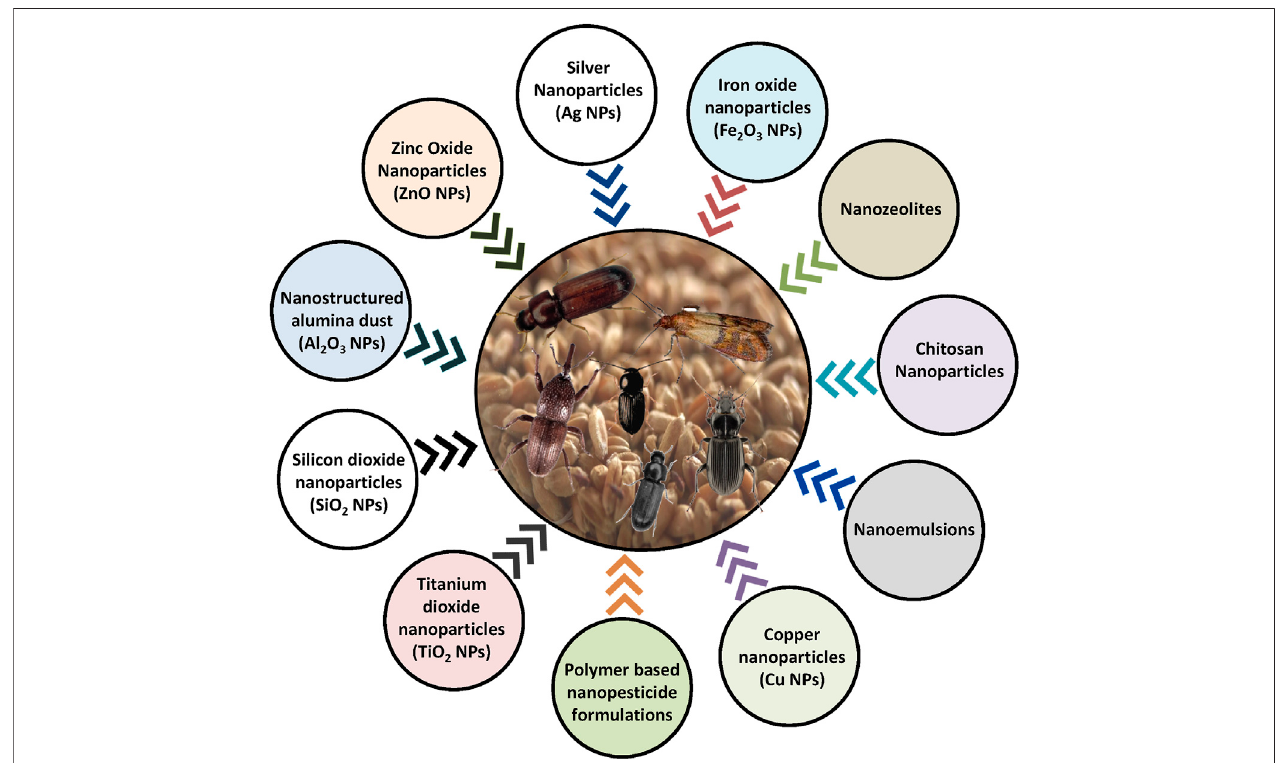
FIGURE 3 | Types of potential nanomaterials and nanoformulations suggested for insect pest management under storage.